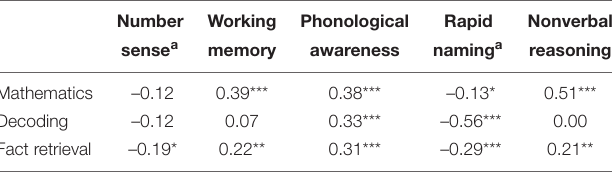
TABLE 5A | Correlations between latent behavioral skills and latent cognitive skills ( n =